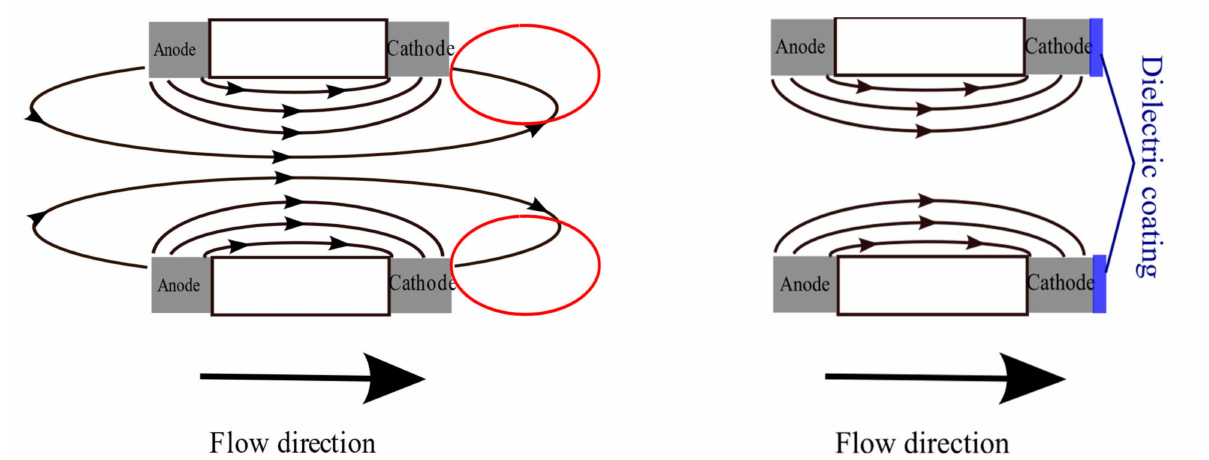
Figure 7. Ion transport in the absence ( left side) and presence of a dielectric coating ( right side). The lines show the movement of ions from the anode to the cathode due to diffusion. Circled in red are the areas of space in which the hydrodynamic transfer of ions leads to a decrease in the output